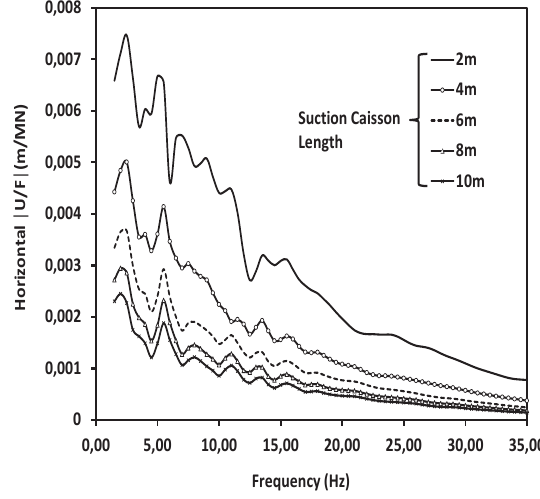
Figure 12: Vertical displacement amplitude │ U/F │. ̶ Figure 13: Horizontal displacement amplitude │ U/F │.